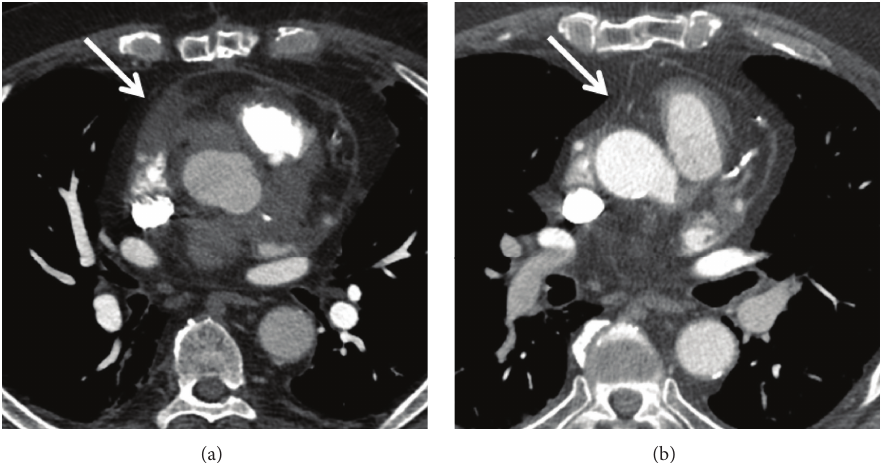
Figure 2: Contrast-enhanced computed tomography, subsequent images through heart in the patient with GPA show soft tissue attenuation around the pericardium (a). Resolution of pericardial thickening after the immunotherapy